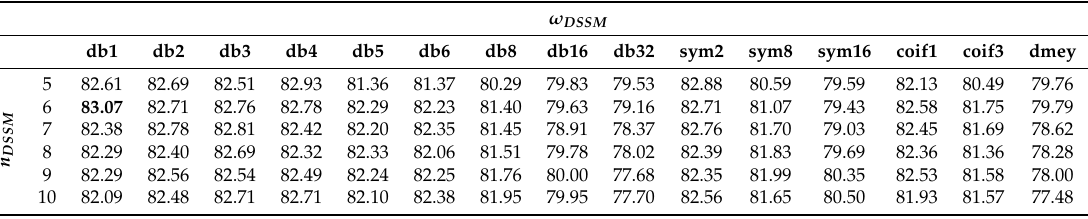
Table 8. The accuracy (%) of four class sleep stage classification with different wavelet bases and different order of DSSM under R&K standard. Only DSSMFs are used, no